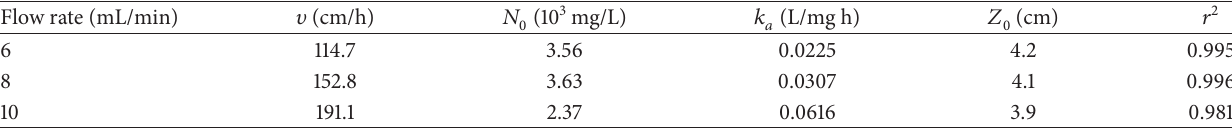
Table 3: Effect of flow rate on BDST model.